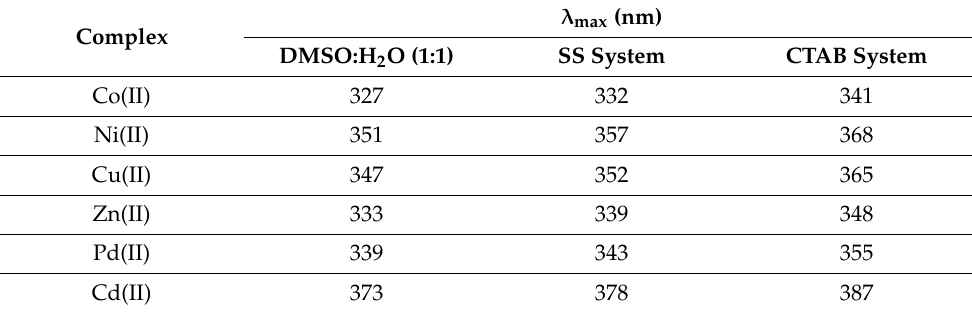
Table 6. Shift in maximum absorbance of M(II) complexes in aqueous and micellar